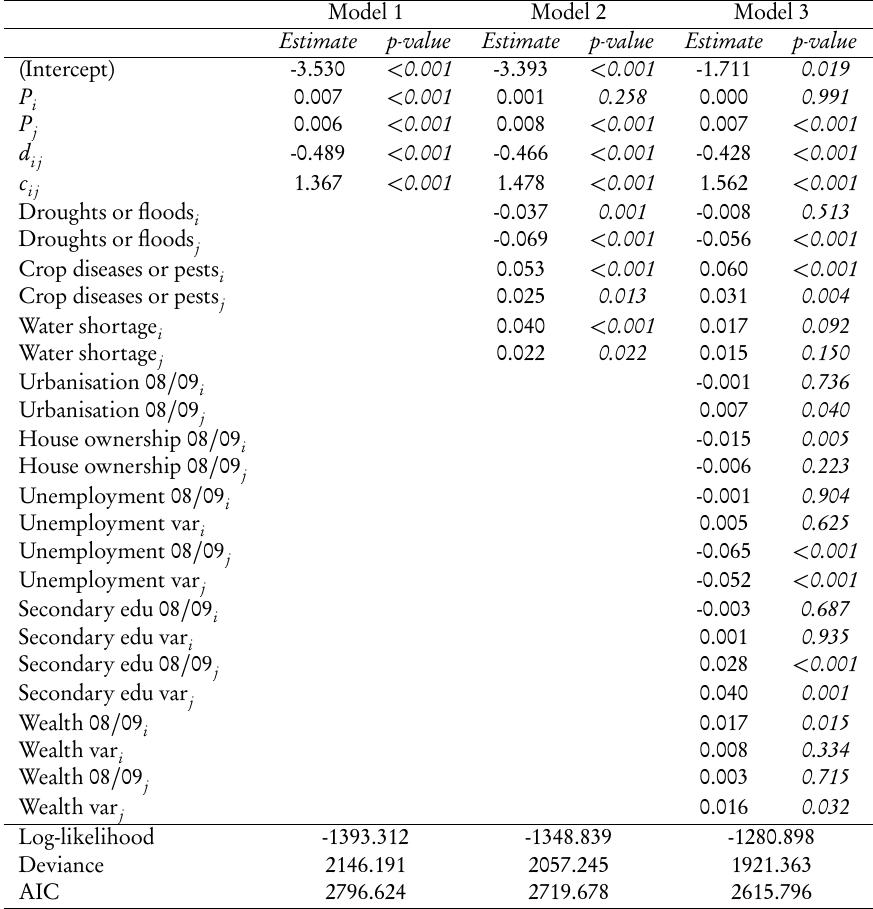
Estimates, standard errors, and p-values of model parameters under different model